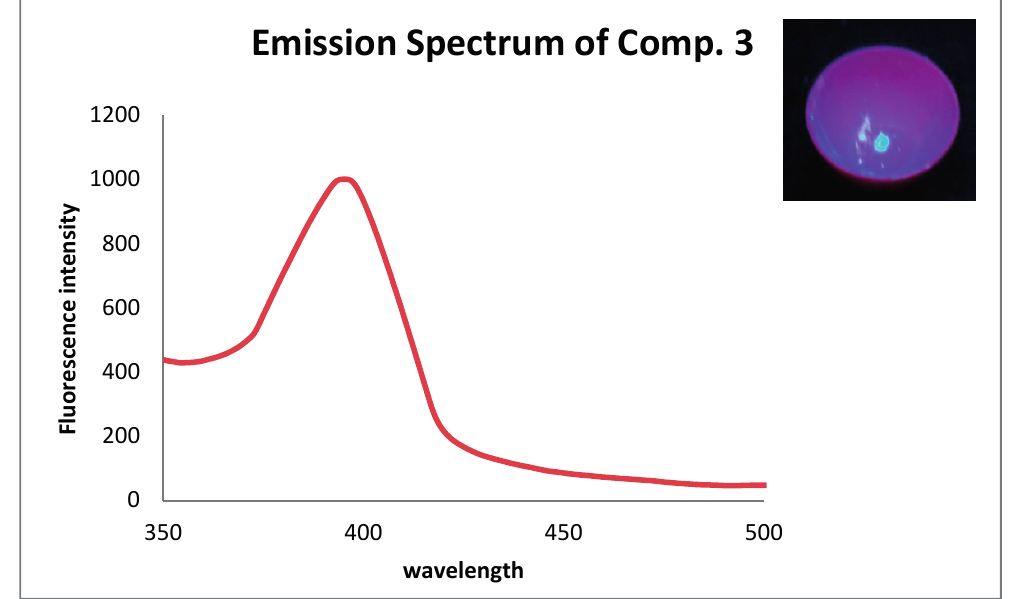
Figure 4. The fluorescence emission spectrum of compound 3 after excitation in 300 nm. The photo in the top right has been taken under a UV lamp with λ = 366 nm (Philips